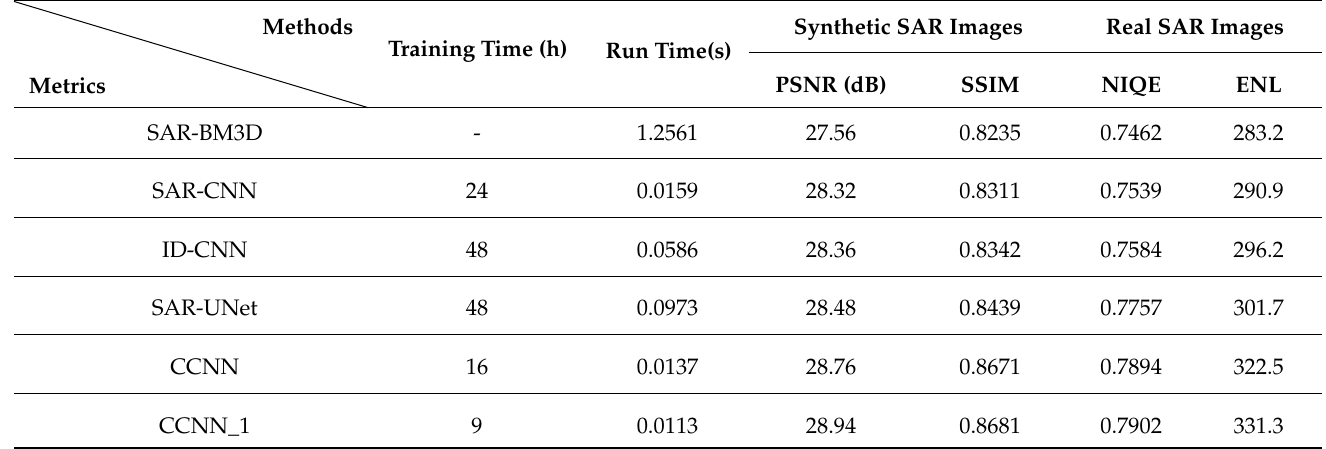
Table 1. Average results of the comparison